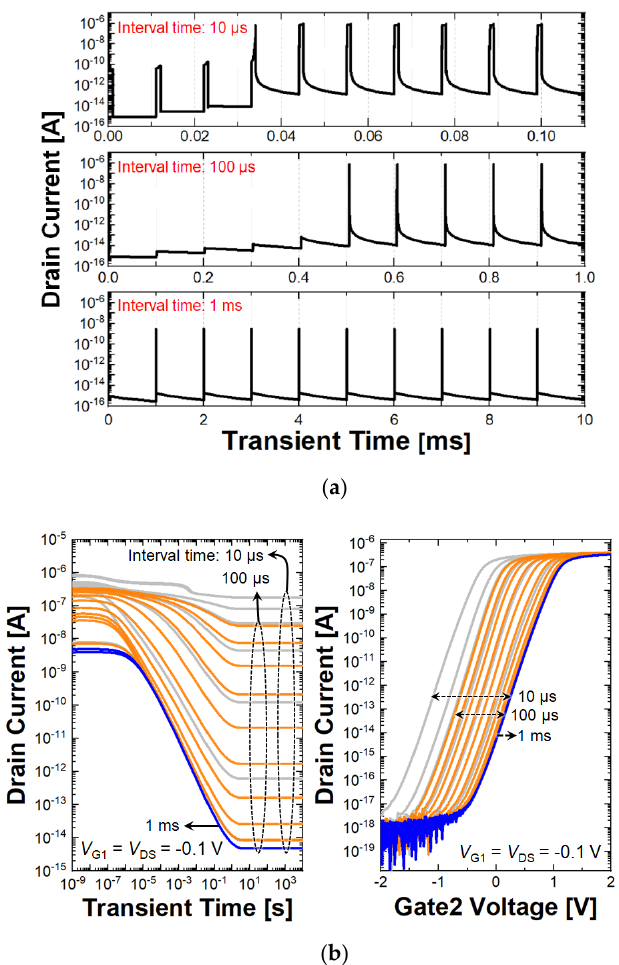
Figure 6. Operation characteristics depending on the number of pulse interval times. ( a ) Current changes with di ff erent pulse interval times: 10 µ s, 100 µ s, and 1 ms. ( b ) Transient (left) and DC sweep (right) characteristics with di ff erent interval times. For a shorter interval time at a given number of potentiation pulses, the saturation current increases and the V th shift gets